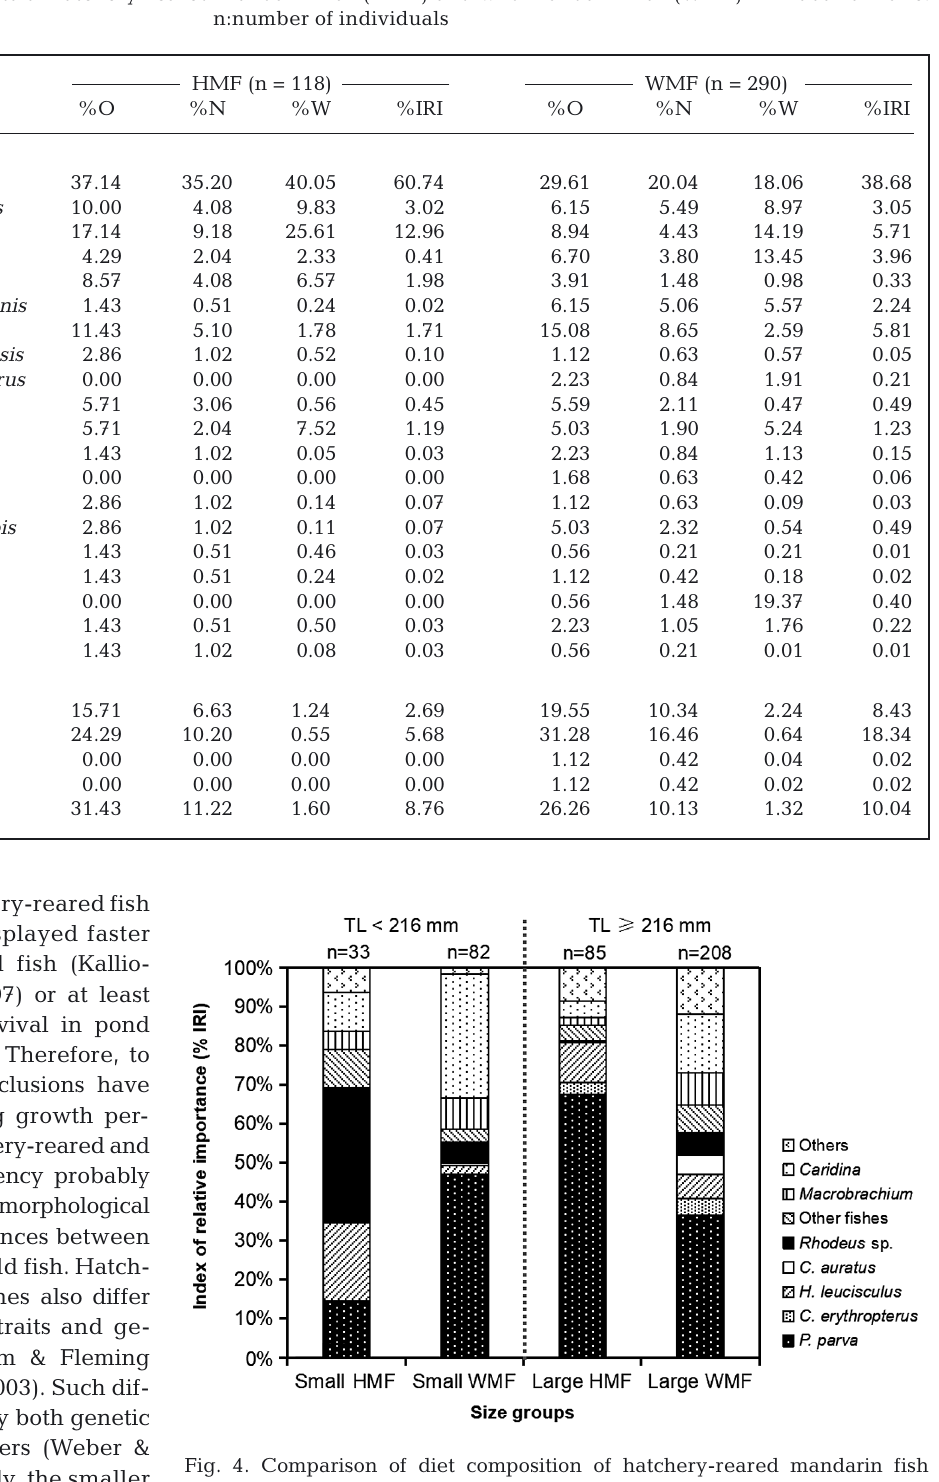
Table 3. Percentage occurrence (%O), number (%N), weight (%W), and index of relative importance (%IRI) of the prey taxa in the stomach contents of hatchery-reared mandarin fish (HMF) and wild mandarin fish (WMF) in Xiaosihai Lake.